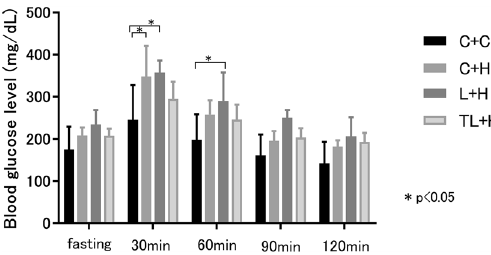
Figure 2. Glucose tolerance test results at 16 weeks in the treatment groups. At 15 weeks, glucose was administered intraperitoneally (1 mg/kg body weight) after an overnight fast. The blood glucose levels 30 min after glucose administration were significantly lower in the TL + H group than in the L + H group. Furthermore, the blood glucose levels at 90 min were higher in the L + H group than those in the other groups. Data are presented as the mean ± standard deviation, n = 4–7/group; **p < 0.01, *p < 0.05, based on a two-way repeated analysis of variance with a post hoc Tukey test for multiple comparisons. C + H control + high-fat diet, HFD high-fat diet, L + H L-NG-nitroarginine methyl ester + high-fat diet, L-NAME L-NG-nitroarginine methyl ester, TL + H L-NG-nitroarginine methyl ester + tadalafil + high-fat